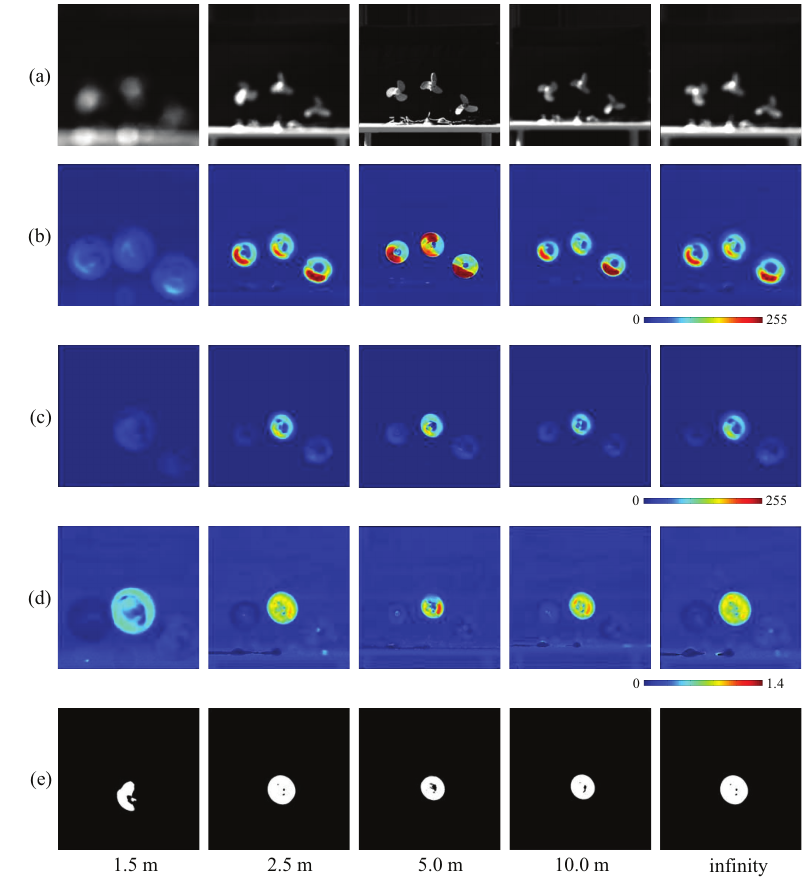
Figure 6. ( a ) Input images; amplitude of ( b ) input; and ( c ) pixel-wise filtered images; ( d ) amplitude ratios; ( e ) extracted vibration features.